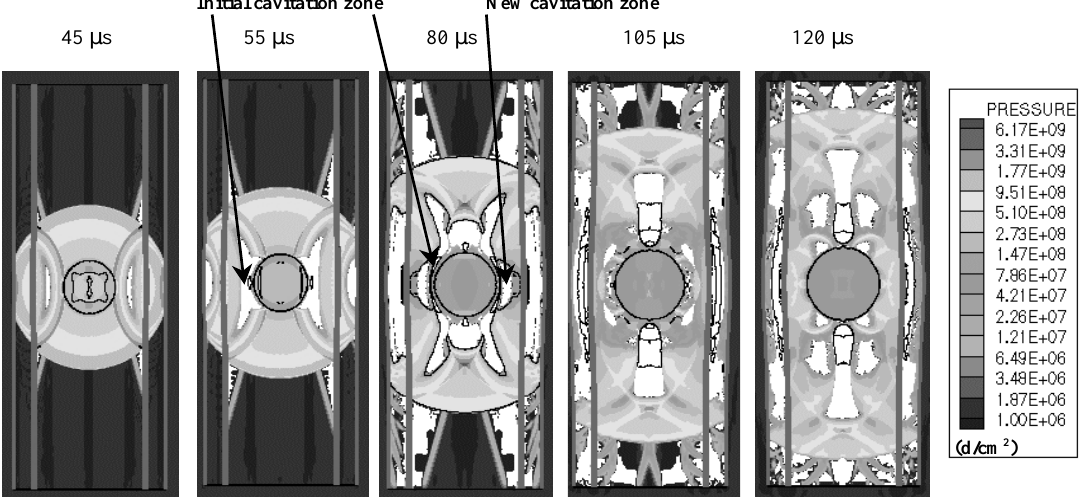
Fig. 15. Pressure contours illustrating the double cylinder flow field cavitation collapse.